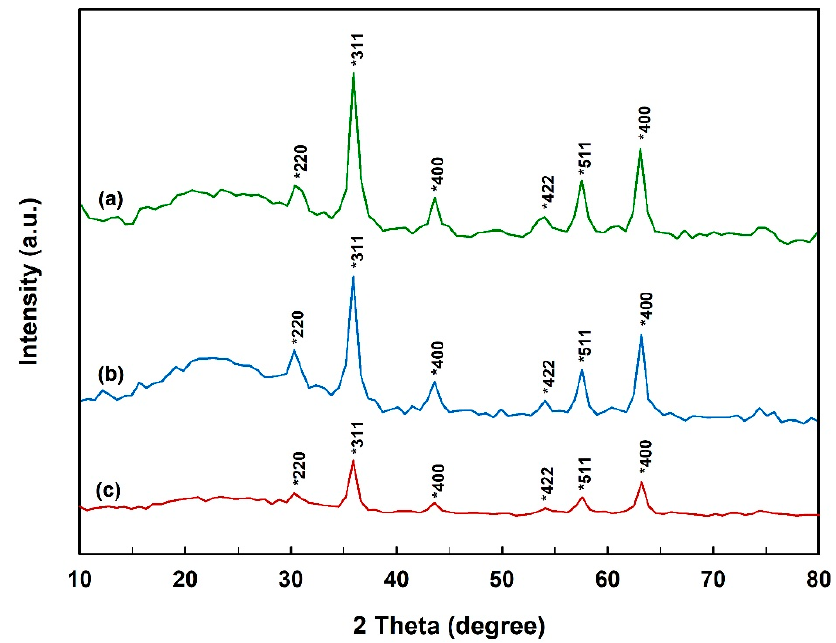
Figure 2. XRD diffractograms of bare ( a ) and APTES-coated ( b ) MNPs, and N450D-mCLEAs ( c ).